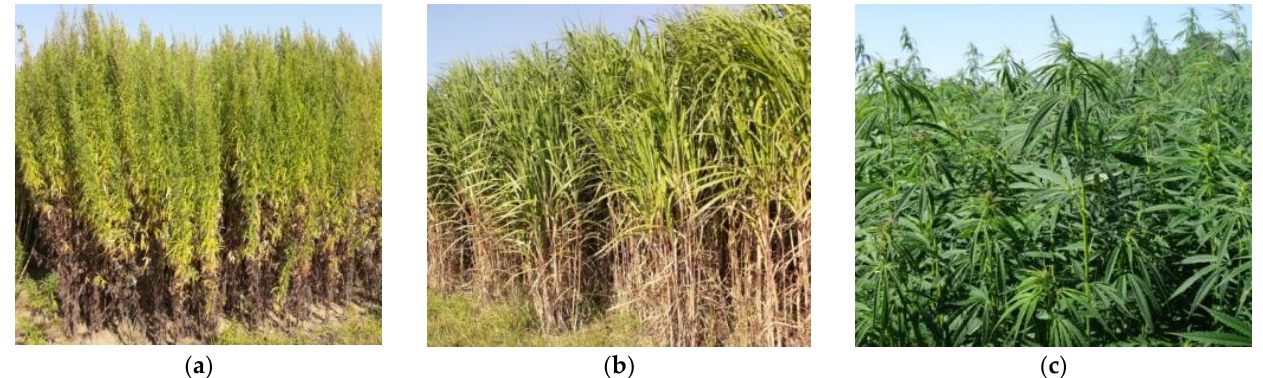
Figure 1. Coarse-energy crops: Artemisia dubia Wall. ( a ), Miscanthus×giganteus ( b ), Cannabis sativa L. ( c ).